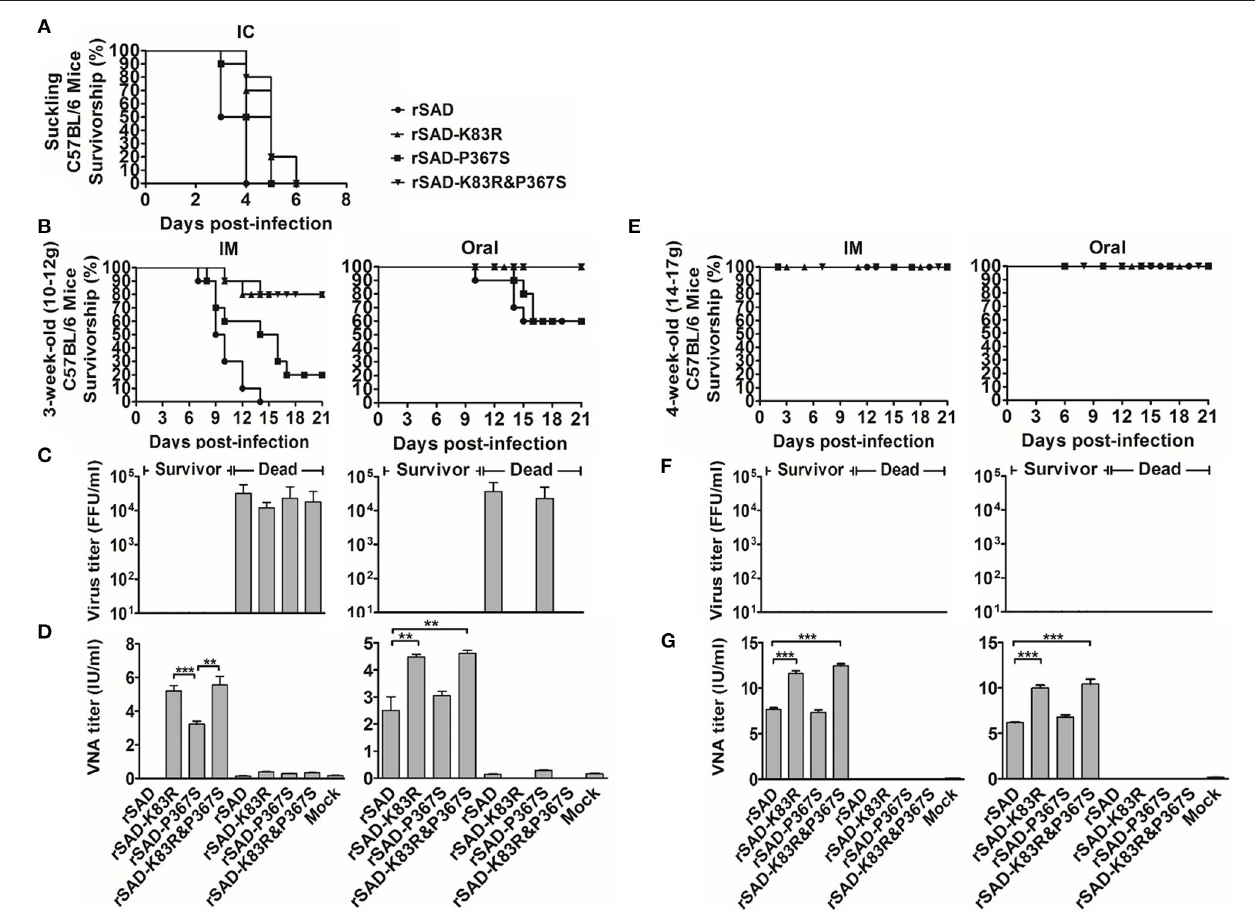
FIGURE 6 | The change of G83 from lysine (K) to arginine (R) in glycoprotein attenuates the pathogenicity of the RABV. (A) The survivorship of 1-day-old C57BL/6 mice was inoculated with the indicated virus by IC. (B,E) The survivorship of 3- (10–12g) and 6-week-old (18–22g) C57BL/6 mice were inoculated with the indicated virus by IM or oral administration. (C,D) The virus titer in the brains of dead and surviving mice, which was inoculated with the indicated virus by IM (left) or oral administration (right). (F,G) The VNA in the blood of dead and surviving mice, which was inoculated with the indicated virus by IM (left) or oral administration (right). Significance of differences between the indicated group was assessed by the unpaired t-test. * p < 0.05; ** p < 0.01; *** p <